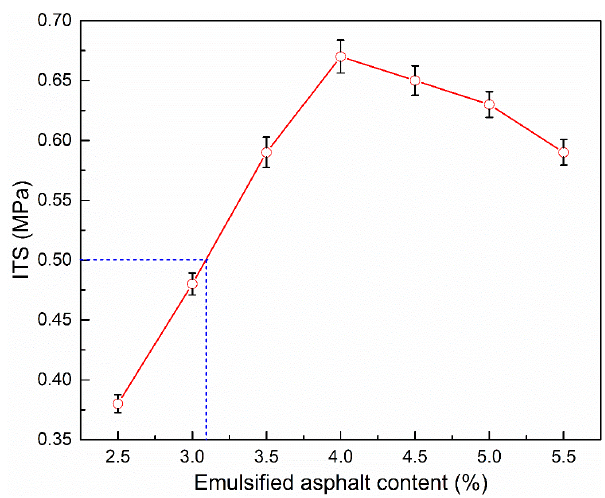
Figure 8. Influence of emulsified asphalt content on ITS.